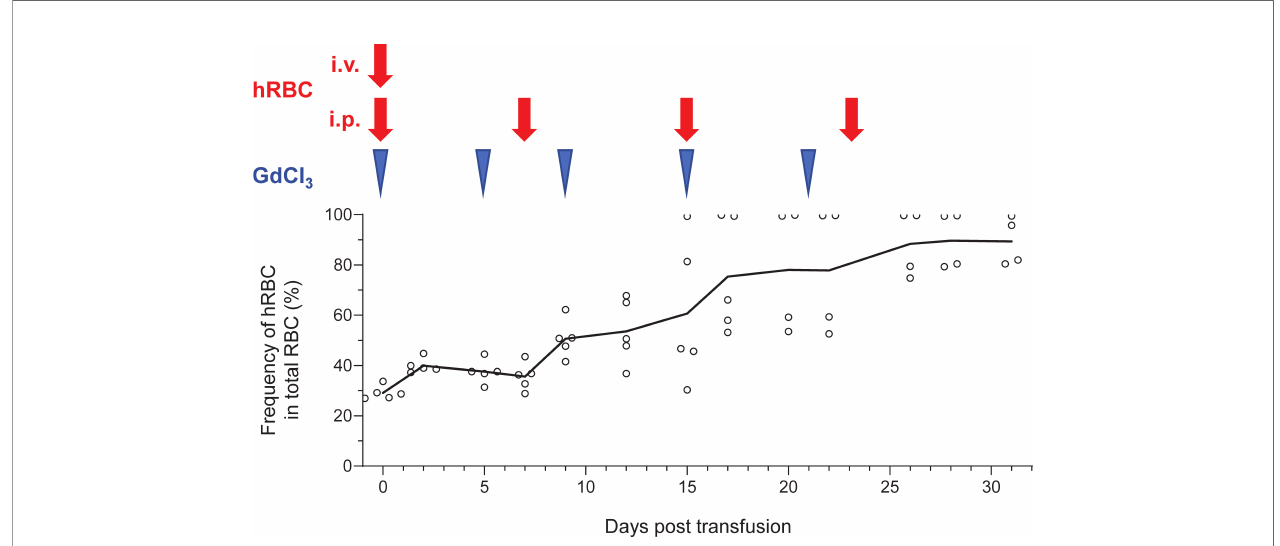
FIGURE 6 | Long-term stable maintenance of hRBCs by repeated administration of hRBCs and GdCl 3 in NOG-C3 D MG2-3 mice. NOG-C3 D MG2-3 mice were treated with Clo-lip once, and subsequently with GdCl 3 three times at 3 – 4-day intervals. Mice were transfused with i.v. (5.0 × 10 9 ) and i.p. (5.0 × 10 9 ) injections of hRBCs on the next day of the pretreatment cycle, to increase the initial number of hRBCs and avoid transient polycythemia. GdCl 3 was administered every 4 – 6 days to suppress murine macrophages. hRBCs were i.p.- injected every 7 – 8 days. The NOG-C3 D MG2-3 group consisted of fi ve mice. The average numbers of hRBCs at the indicated time points are shown, along with the values from each individual mouse. Blue arrow heads and red arrow represent administration of GdCl 3 and hRBC supplementation,